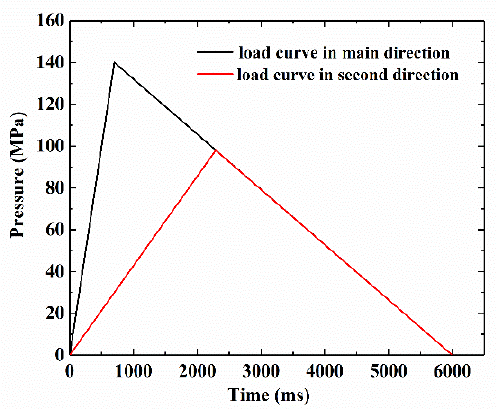
Figure 9. Loading curves of the model.